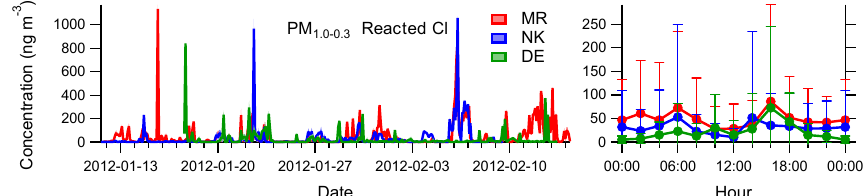
Figure 10. Time series (left) and diurnal variations (right) of the reacted Cl factor at MR, NK and DE for PM 1 . 0–0 . 3 . Time series show the mean of all good solutions ± 1SD as shaded areas. Diurnals show the mean of the time series ± 1SD as whiskers, with the hour being the start of a 2h sampling period (00:00UTC means sampling from 00:00 to 02:00UTC).